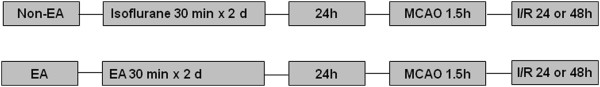
Diagram of experimental protocol. Non-EA, animals received no EA treatment but isoflurane inhalation the same as the EA group; EA, preconditioning with EA for 30 min daily for two consecutive days before MCAO. EA, electroacupuncture; MCAO, middle cerebral artery occlusion.